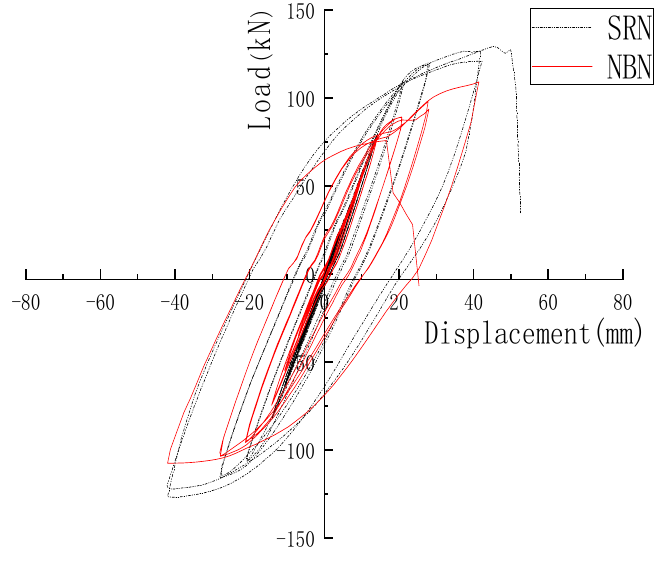
Figure 6. Hysteresis curve .